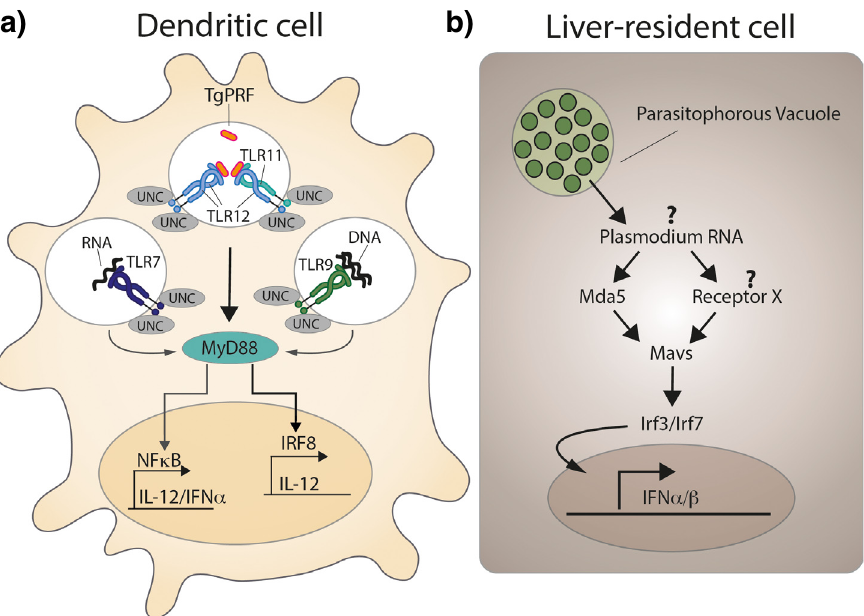
Figure 4. Innate sensing of Toxoplasma gondii and Plasmodium sp. by host cells. a) Simplified model of how dendritic cells sense T. gondii infection. Toll-like receptor 11 (TLR11) and TLR12 are the major receptors for the T. gondii -derived protein profilin ( Tg PFR). Interferon regulatory factor 8 (IRF8) + dendritic cells (DCs), in particular CD8 + DCs, have a crucial role in detecting T. gondii profilin and in the subsequent induction of interleukin (IL)-12 production downstream of myeloid differentiation primary-response protein 88 (MYD88). A novel MYD88-dependent signaling pathway that depends on activation of IRF8 is an explanation for the potent induction of IL-12 expression by CD8 α + DCs that have been exposed to T. gondii , but the direct connection between MYD88 and IRF8 has not been established. In addition, both TLR7 and TLR9 have been implicated in detecting T. gondii RNA and genomic DNA, respectively. UNC93B1 (UNC), an endoplasmic reticulum-resident protein, has a central role in the function of all of the depicted endosomal TLRs and is essential for resistance to T. gondii (modified and redrawn from 132). b) Schematic representation of the proposed sequence of events occurring in liver-resident cells upon Plasmodium sp. infection. Plasmodium RNA triggers a type I interferon response via activation of the cytoplasmic RNA sensor Mda5 and other unknown receptors, mitochondrial antiviral signaling protein (Mavs), and the transcription factors interferon regulatory factor 3 (Irf3) and Irf7 (modified and redrawn from